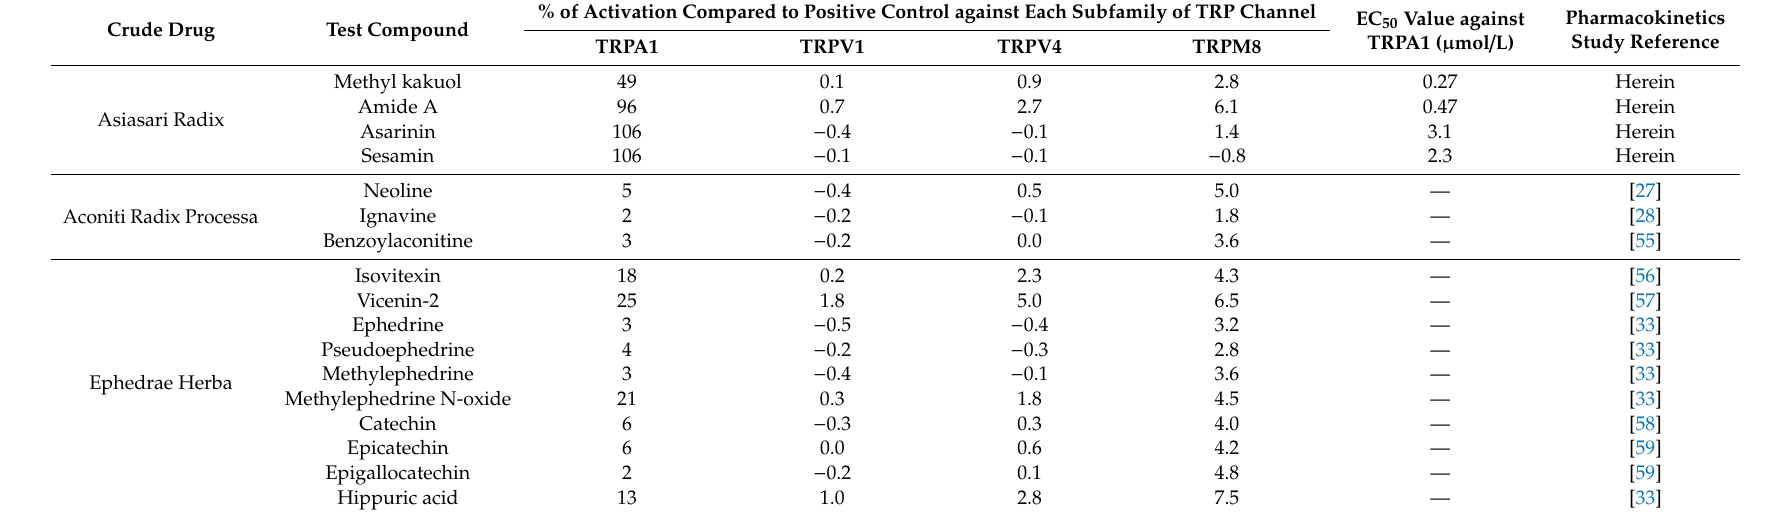
Table 3. Agonistic e ff ect of maobushisaishinto ingredients against TRP